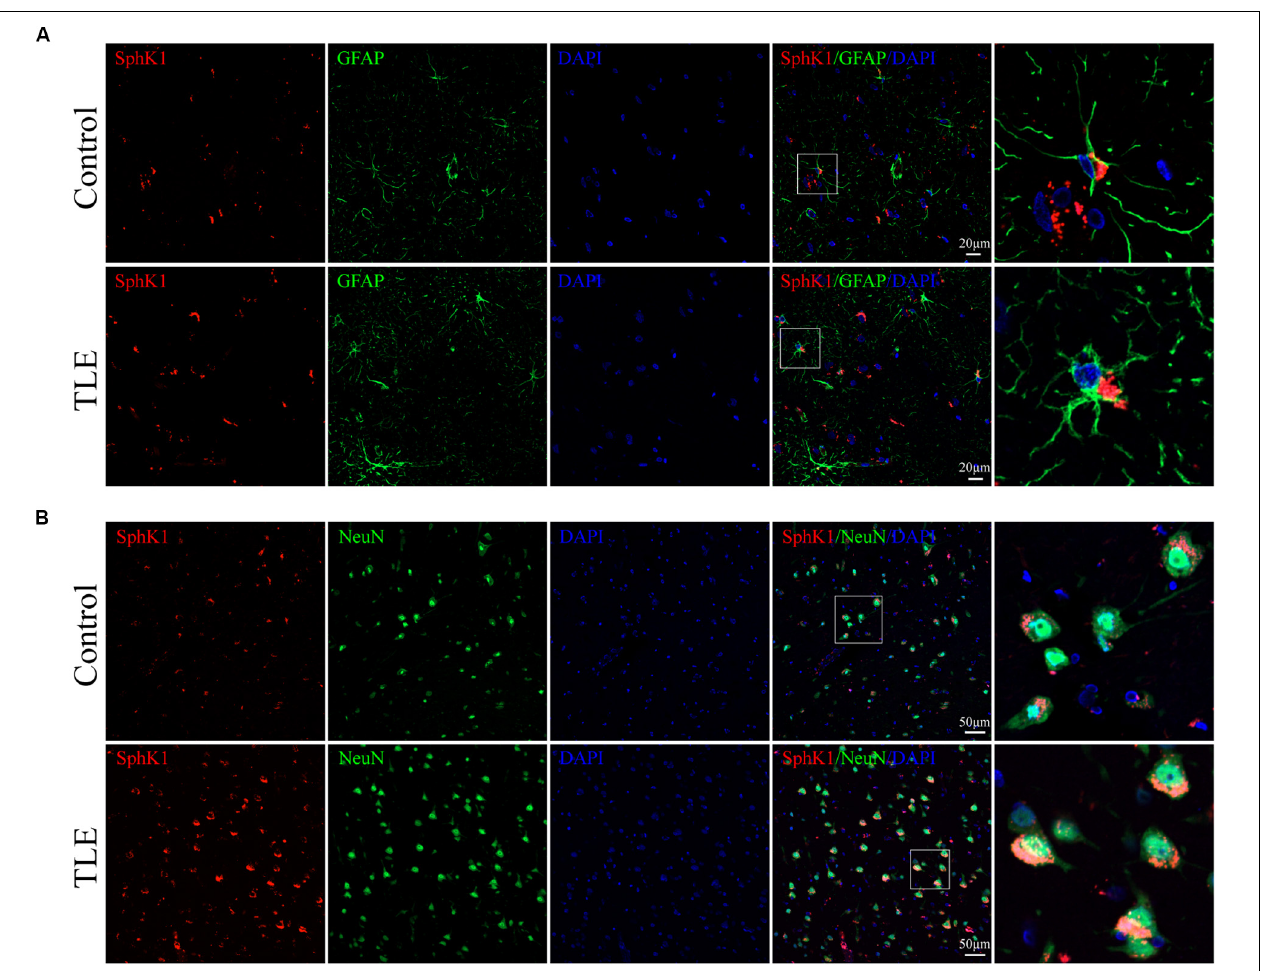
FIGURE 8 | Cellular localization of SphK1 in temporal cortex tissues from patients with drug-resistant TLE patients. ( A , left) Confocal images showing co-localization of SphK1 and DAPI in astrocytes. ( A , right) Enlarged view of indicated co-localization between SphK1 with astrocytes. ( B , left) Confocal images showing co-localization of SphK1 and DAPI in neurons. ( A , right) Enlarged view of indicated co-localization between SphK1 with